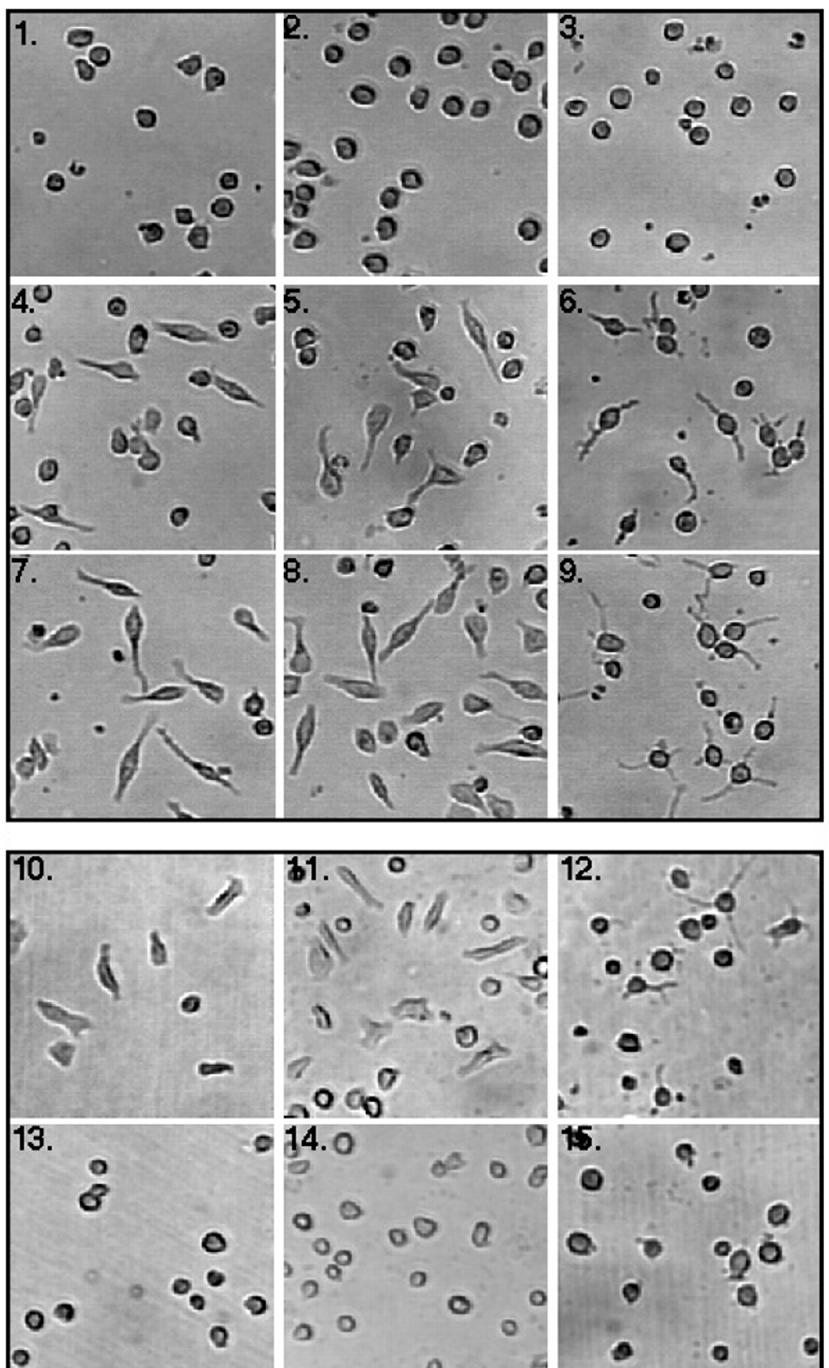
ADP-ribosylation of Rho alters HPB-ALL spreading on β 1 integrin substrates. Cells were plated on BSA (panels 1–3), Fn (pan- els 4–6), VCAM-1 (panels 7–9), anti- β 1 mAb 33B6 (panels 10–12), or poly-L-lysine (panels 13–15). HPB-ALL cells were elec- troporated with 25 µ g/ml C3 (right column), 25 µ g/ml BSA (middle column), or untreated (left column). Initial magnification was 200 ×. Experiments in panels 1–9 and panels 10–15 were performed separately. The images are representative of at least four separate